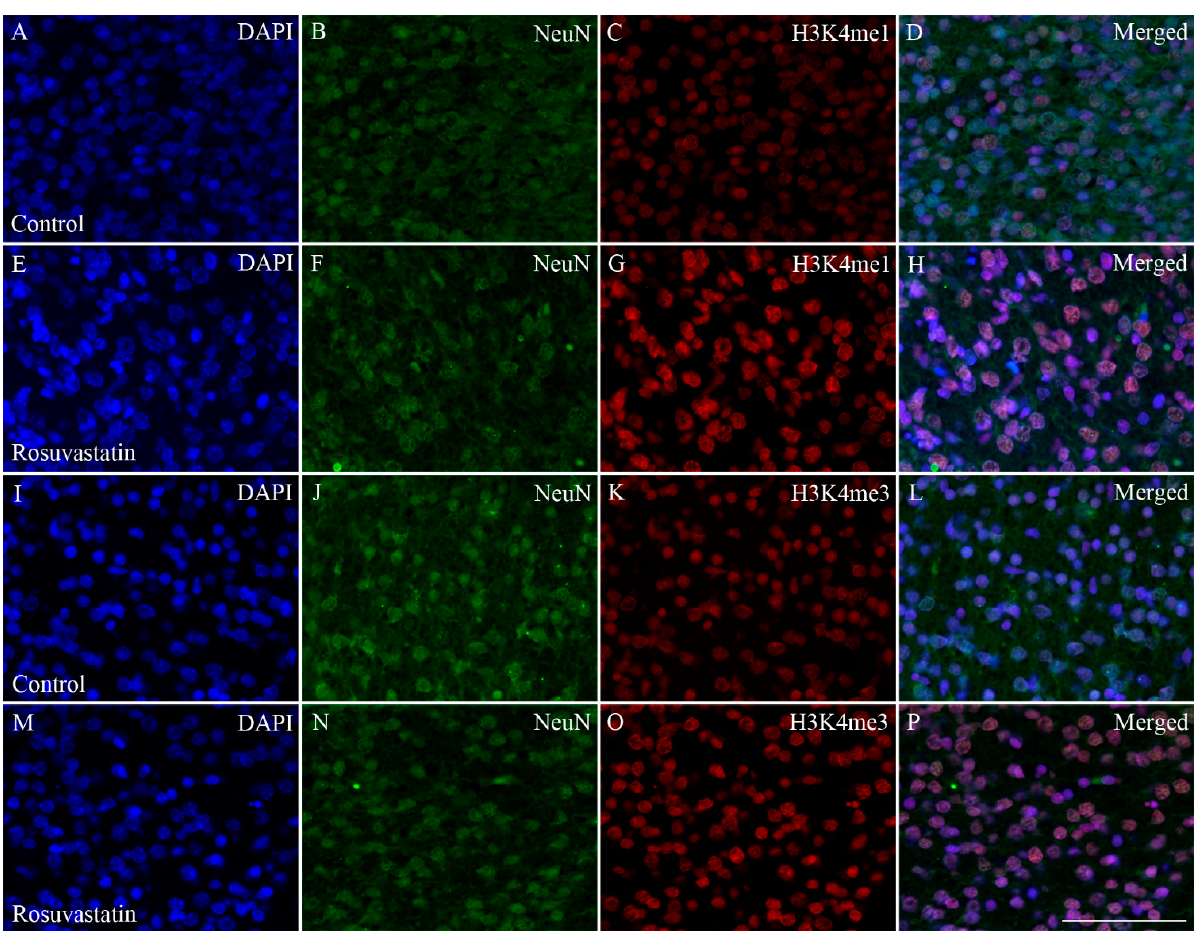
Figure 7. Colocalization of H3K4 methylation patterns and NeuN immunoreactivity in neurons of the newborn brain. DAPI-labeled cell nuclei are shown in blue ( A , E , I , M ). Immunoreactivity of the neuron-specific marker NeuN ( B , F , J , N ; shown here in green) and the histone methylation markers H3K4me1 and H3K4me3 ( C , G , K , O , respectively; shown here in red) were colocalized in merged images ( D , H , L , P ). These immunohistochemical data corroborated the results of the Western blot analyses, as the immunofluorescent signals of the methylation marks were more intense in the sections from the RST-exposed newborns ( G , O ) as compared to the controls ( C , K ). Scale bar: 75 µm.